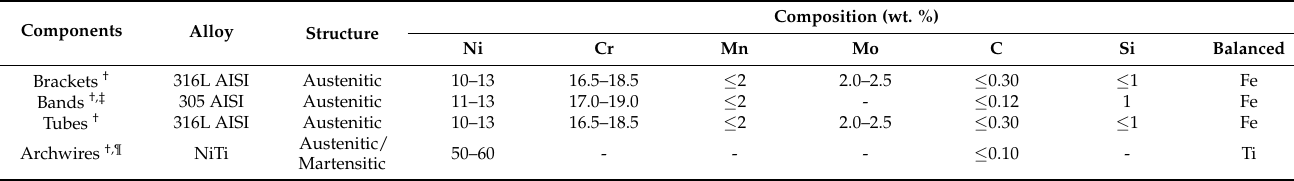
Table 2. Nominal chemical composition of the commercially available fixed orthodontic appliances used, according to the